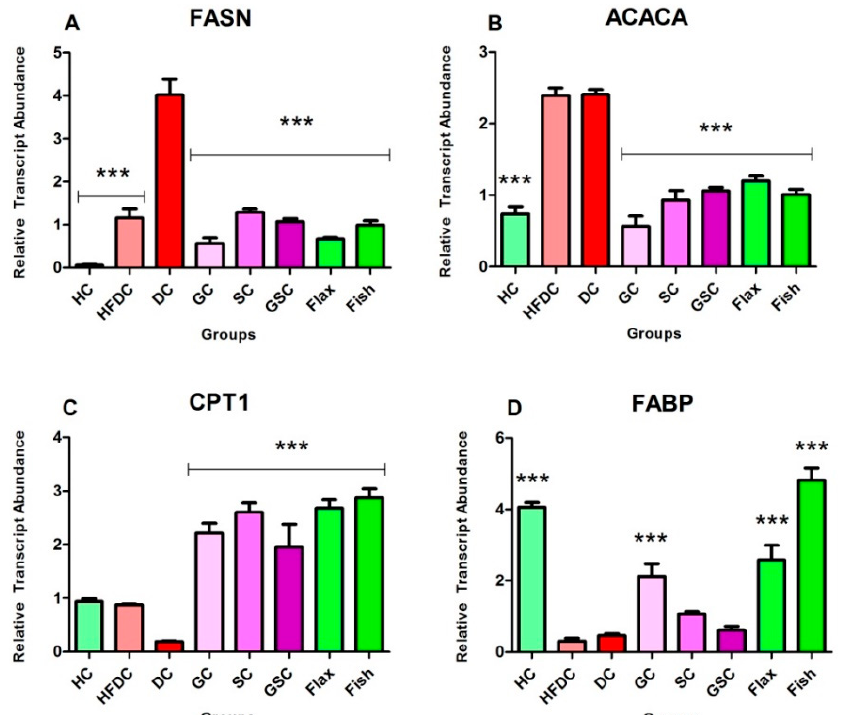
Figure 9. Expression profiles of fatty acid metabolism genes. Results are denoted as Mean ± SE ( n = 3 for each group). *** p ≤ 0.001, when compared with the DC group (Dunnett’s Multiple Comparisons Test). ( A ) Expression of fatty acid synthase gene, ( B ) Expression of acetyl-CoA carboxylase alpha gene, ( C ) Expression of carnitine palmitoyl transferase 1 gene, ( D ) Expression of fatty-acid-binding proteins gene. HC: Healthy control, HFDC: High fat diet control, DC: Diabetic control, ACACA: Acetyl-CoA carboxylase alpha, FASN: Fatty acid synthase, CPT1: Carnitine palmitoyl transferase 1, FABP: Fatty-acid-binding proteins.